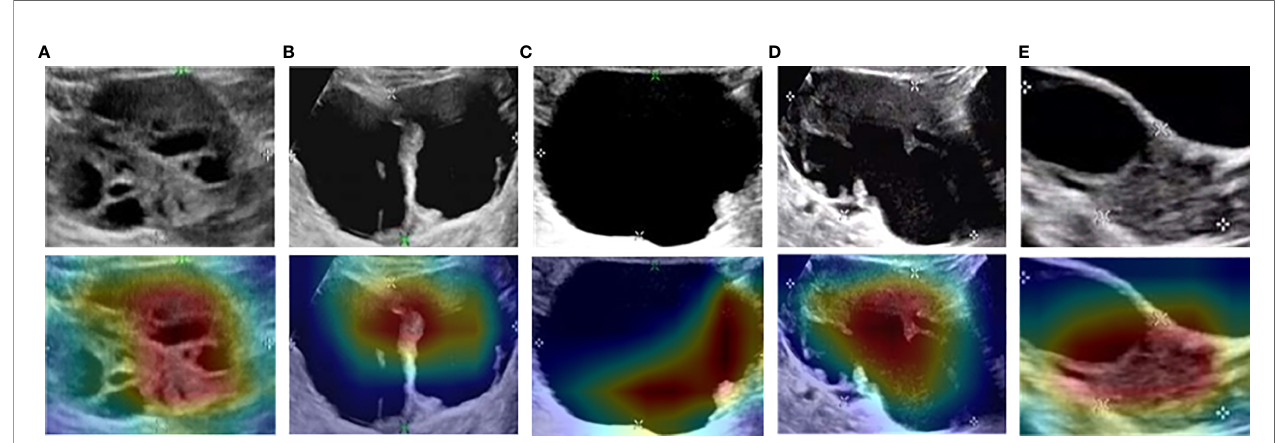
FIGURE 4 | Examples of class activation mapping using the transfer learning ResNet34 model. The model correctly identi fi ed malignant (A) , borderline (B) , and benign (C) SOTs. Both the model and the senior sonographer made the same mistakes: borderline SOT misdiagnosed as malignant SOT (D) ; and malignant SOT misdiagnosed as borderline SOT (E) .